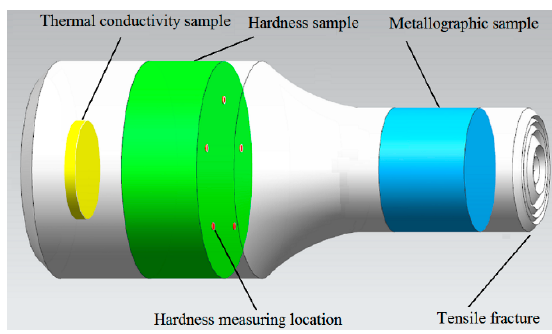
Figure 2. Schematic diagram of samples cutting sites and hardness measurement locations.